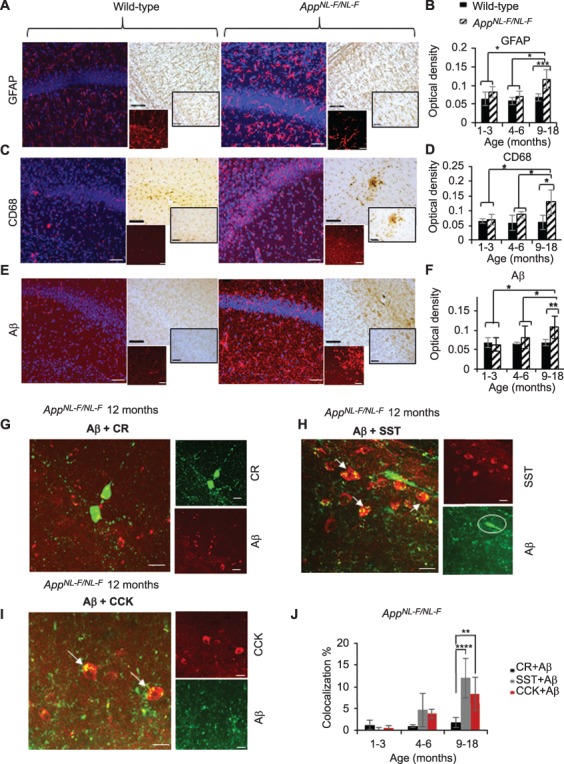
Age-dependent phenotypical changes in the AppNL-F/NL-F model of AD. (A,C,E) Z-stack images from confocal microscopy illustrating the expression of GFAP (for reactive astrocytes), CD68 (for microglia), and Aβ (all in red, secondary antibody Texas Red) together with DAPI staining for nuclei (in blue) in 12-month age-matched wild-type and AppNL-F/NL-F mice, respectively. Similarly, bright-field images of tissue immunostained with biotinylated antibodies show conglomerates of GFAP, CD68, and Aβ in the same animals. Both immunofluorescence and immunoperoxidase-stained images taken at ×20 magnification (larger images, scale bar = 50 μm) and ×63 magnification (inserts, scale bar = 20 μm). (B,D,F) Analysis of GFAP, CD68, and Aβ from immunoperoxidase-stained tissue. Significant differences in the three markers of AD were seen between wild-type and AppNL-F/NL-F mice only at 9–18 months and when comparing quantification at 9–18 months with the other two age cohorts. (G,I) Age-dependent accumulation of Aβ in selective subtypes of interneurons in hippocampal CA1. Aβ colocalization was found at significantly higher levels in SST and CCK cells (indicated by arrows), but not in calretinin (CR) cells in the same animals at 12 months (scale = 20 μm). (J) Quantification of colocalization of Aβ with either CCK, SST, or calretinin cells. A two-way ANOVA was performed with pairwise comparisons corrected for multiple comparisons (α = 0.05), with either post hoc Sidak’s test or Tukey’s test for multiple comparisons. *P < 0.05, **P < 0.01, ***P < 0.001.